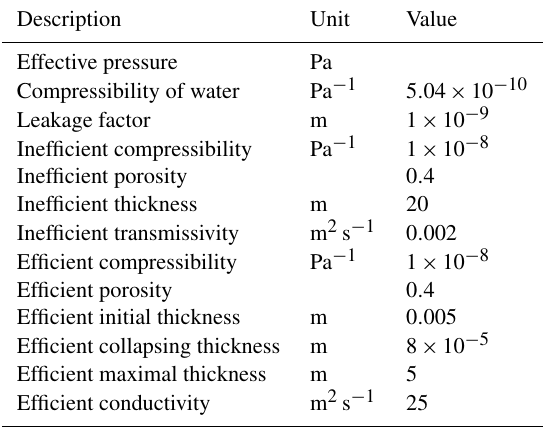
Table 1. Definitions and values of variables in the subglacial hy- drology